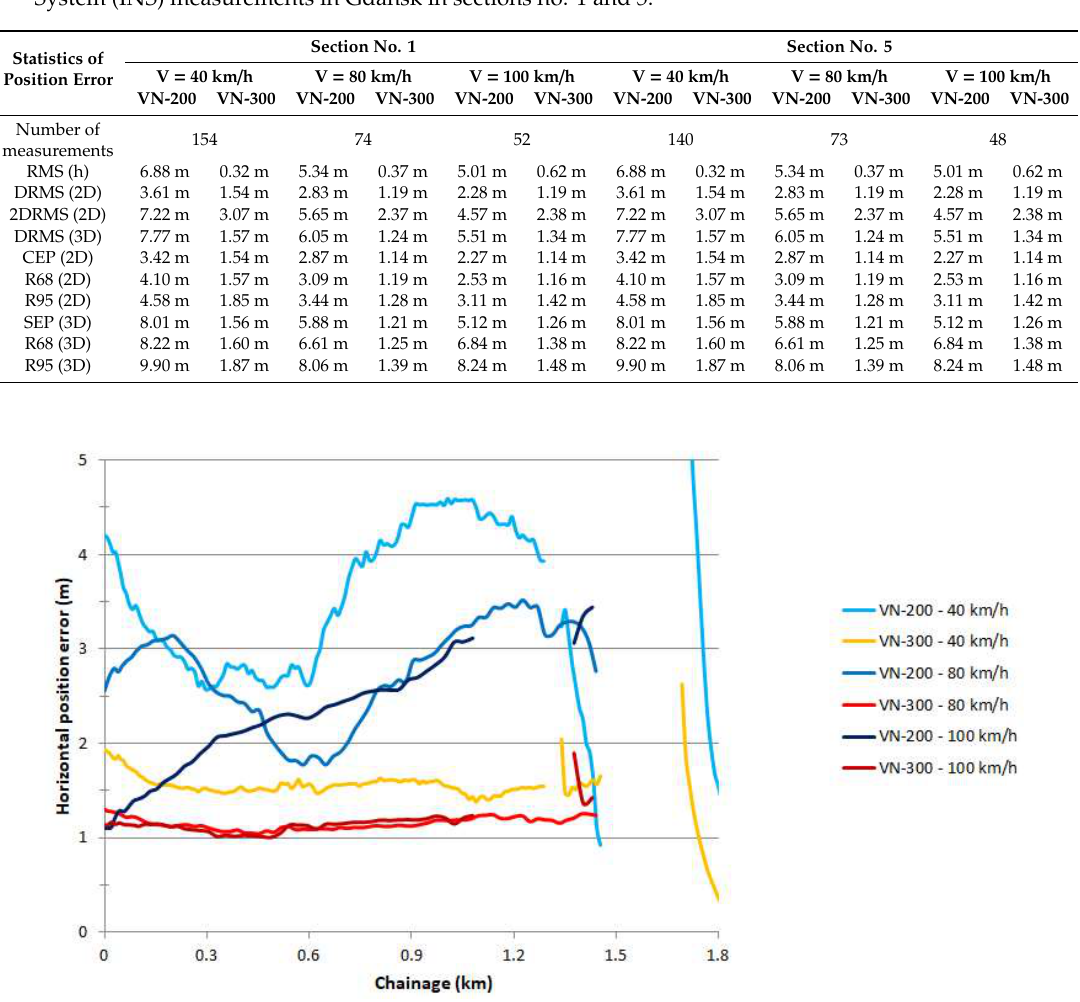
Table 6. Predictable positioning accuracy of VN-200 and VN-300 systems during Inertial Navigation System (INS) measurements in Gda´nsk in sections no. 1 and 5.